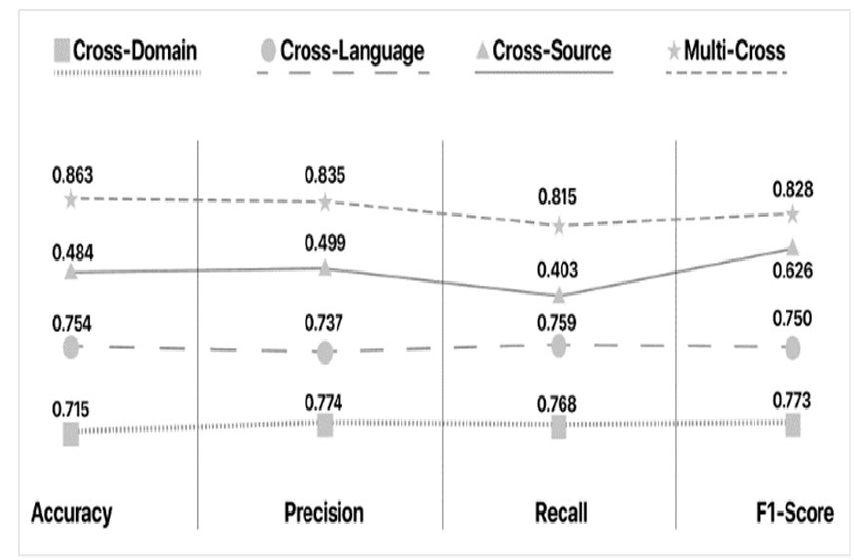
Figure 3. Average performance per Cross-Category.